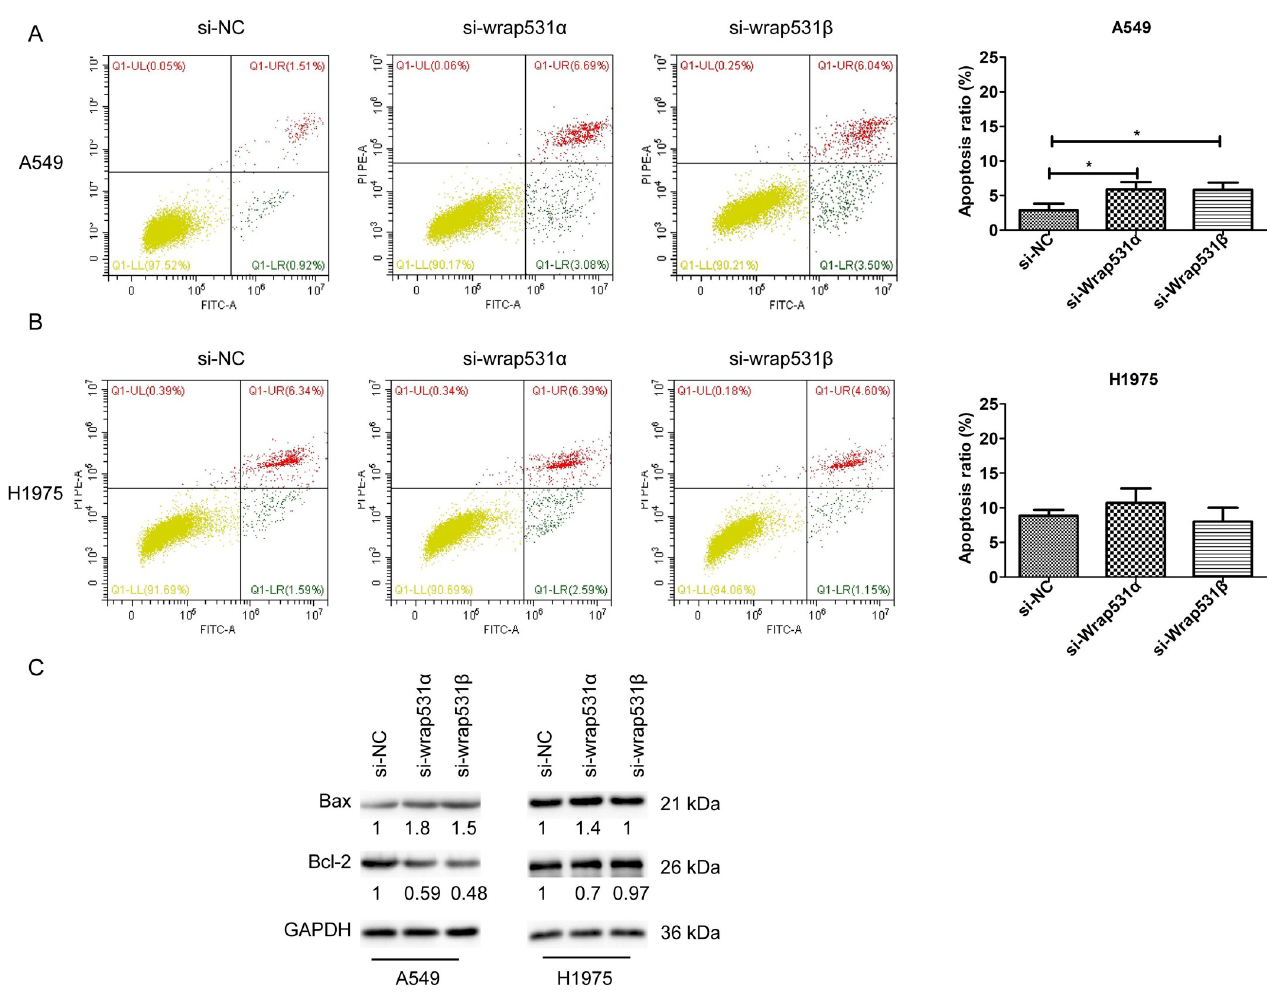
Fig 3. Knockdown of WRAP53 - 1 α and WRAP53-1 β promotes apoptosis in A549 cells but not in H1975 cells. (A) Knockdown of WRAP53 - 1 α and WRAP53-1 β increased apoptosis in A549 cells. N = 3; � , P < 0.05. (B) Flow cytometry indicated that there was no significant difference in apoptosis in H1975 cells transfected with control, WRAP53 - 1 α , or WRAP53-1 β siRNA. (C) Protein levels of the apoptosis-related markers, Bax and Bcl-2, were assessed by